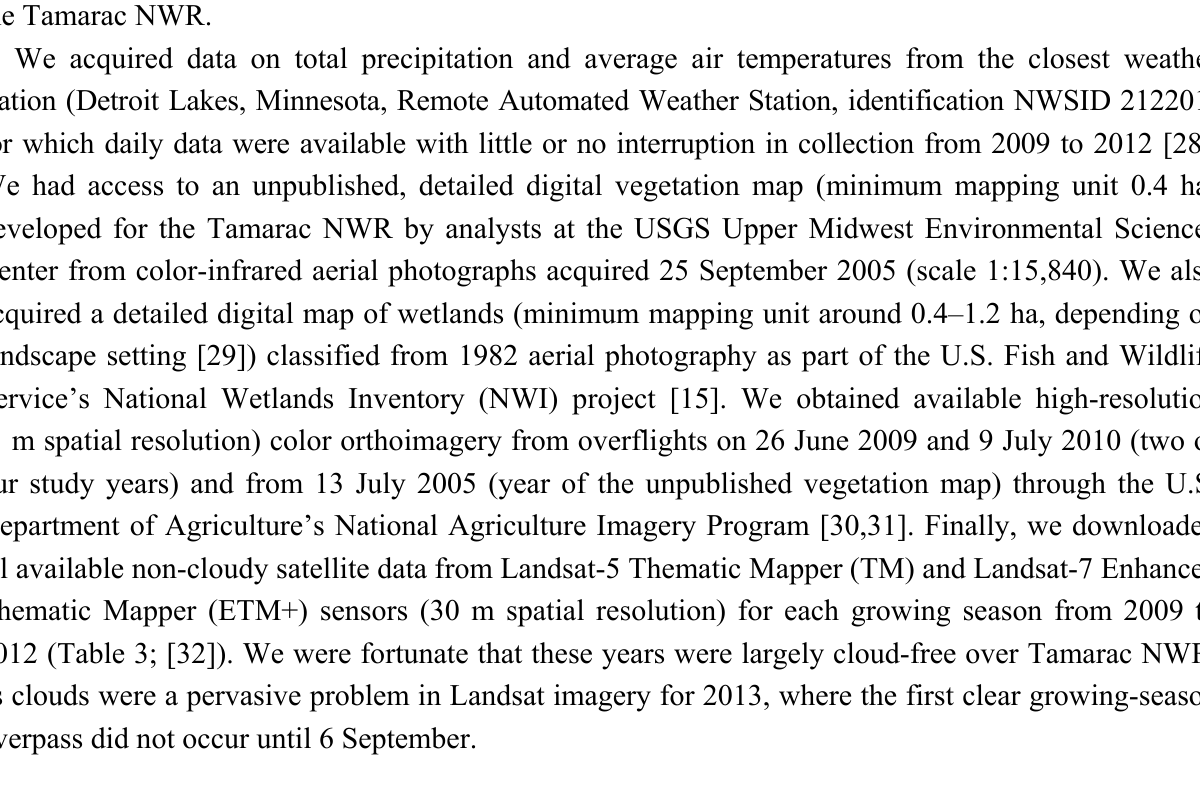
Table 3. Overpass dates for Landsat sensor data for the scene defined by Path 29/Row